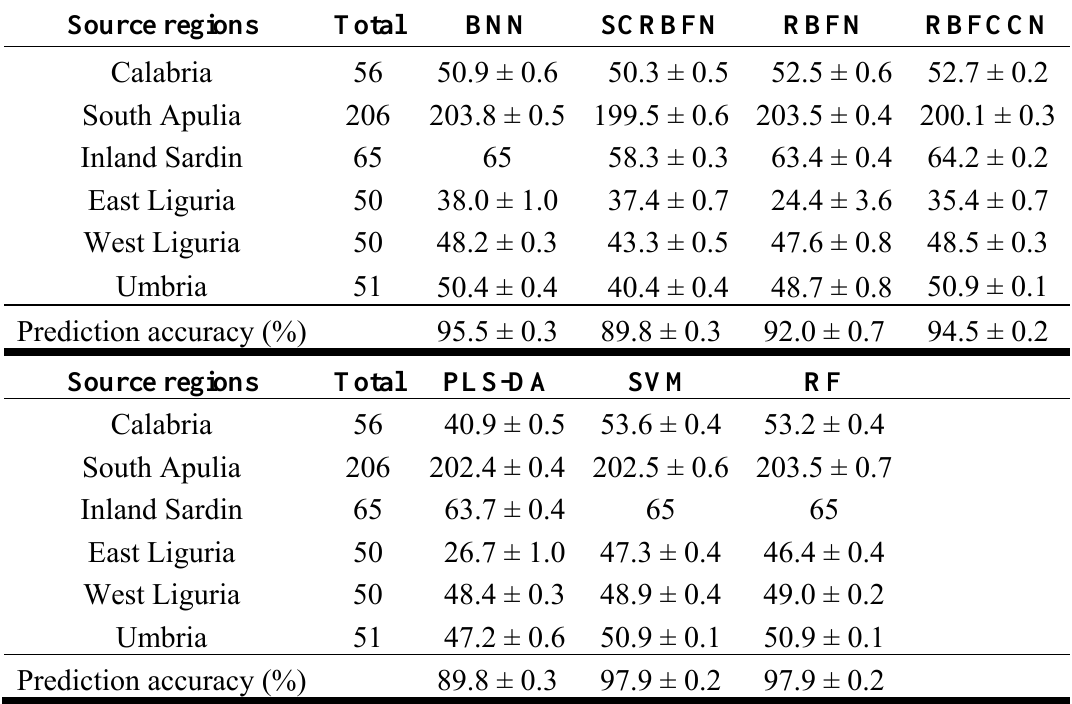
Table 6. Average numbers of correctly predicted objects with 95% confidence intervals of Italian olive oil data set by different modeling methods with 30 BLPs.